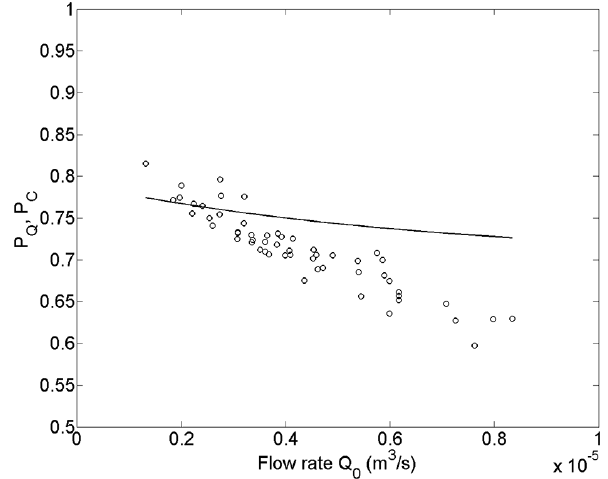
Figure 10. Comparison between the probability of water distribu- tion P Q evaluated as the square brackets term in Eq. (29) (straight line) and the probability of particle transition P C ( P Q ) for ENM3 (circle) varying the injection flow rate Q 0 (m 3 s − 1